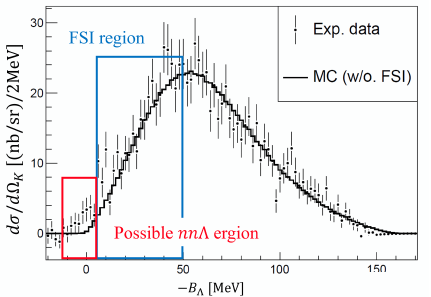
Figure 1. 3 H( e , e ′ K + ) X missing mass spectrum. The horizontal and vertical axes indicate the bind- ing energy of the Λ (MeV) and the di ff erential cross section of the missing mass (nb / sr / 2 MeV), respec- tively. The black points with bar shows the experi- mental data. The black solid line is the simulation result (SIMC) of the Λ -QF distribution without any fi nal state interaction e ff